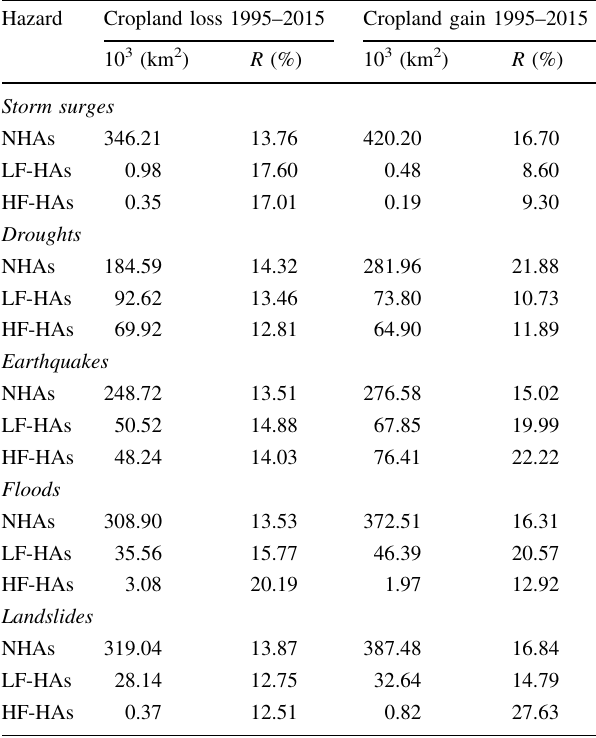
Table 3 Cropland loss and gain from 1995 to 2015 in the non-hazard areas (NHAs), low-frequency hazard areas (LF-HAs), and high-fre- quency hazard areas (HF-HAs) for different hazard types in China ( R : overall change rate from 1995 to